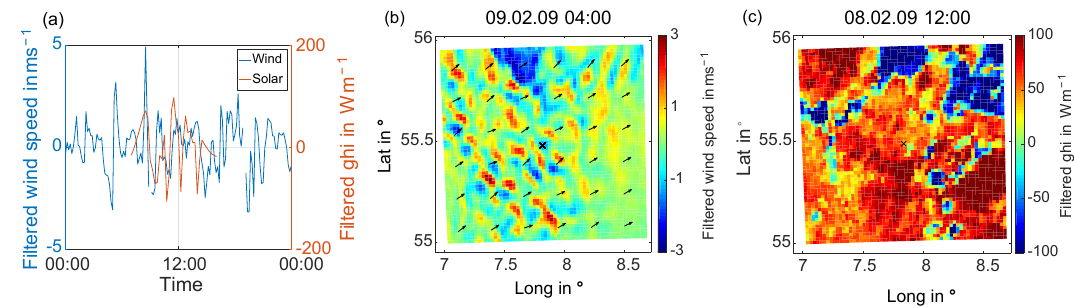
Figure 6. Fluctuation time series and spatial field for a cellular convection case. Panel (a) shows a filtered measurement at a wind turbine whose position is marked in (b) and the filtered solar time series for the measurement point, marked in (c) . Panel (b) shows the WRF fluctuation wind field and (c) the solar fluctuation field. Because of the phase shift between the measurements and the WRF simulation, (b) shows a later time step.